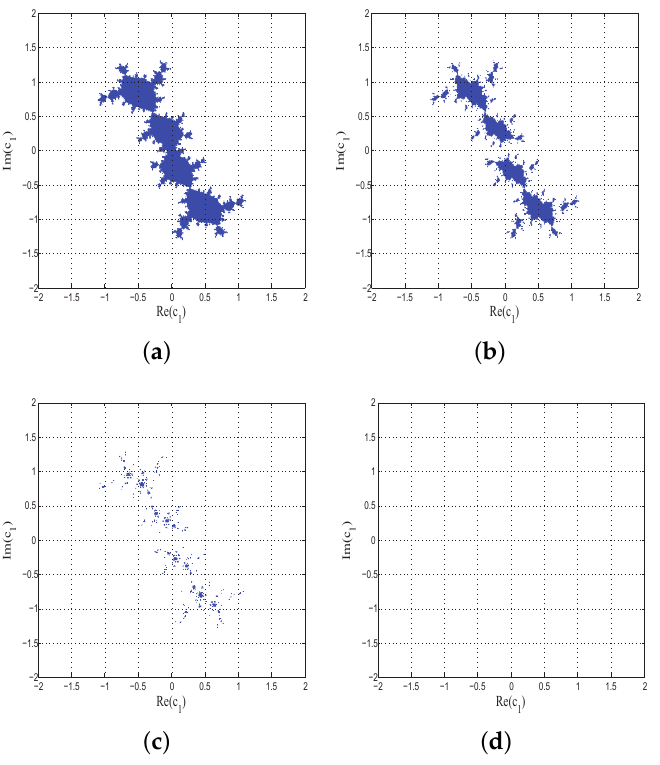
) ; ( b ) K ( P Figure 5. ( a ) K ( P c c 1 = 0.42 + 0.95 i , c 2 = 0.3 i 1 = 0.42 + 0.91 i , c 2 = 0.3 i ) ( d ) K ( P c 1 = 0.42 + 0.99 i , c 2 = 0.3 i